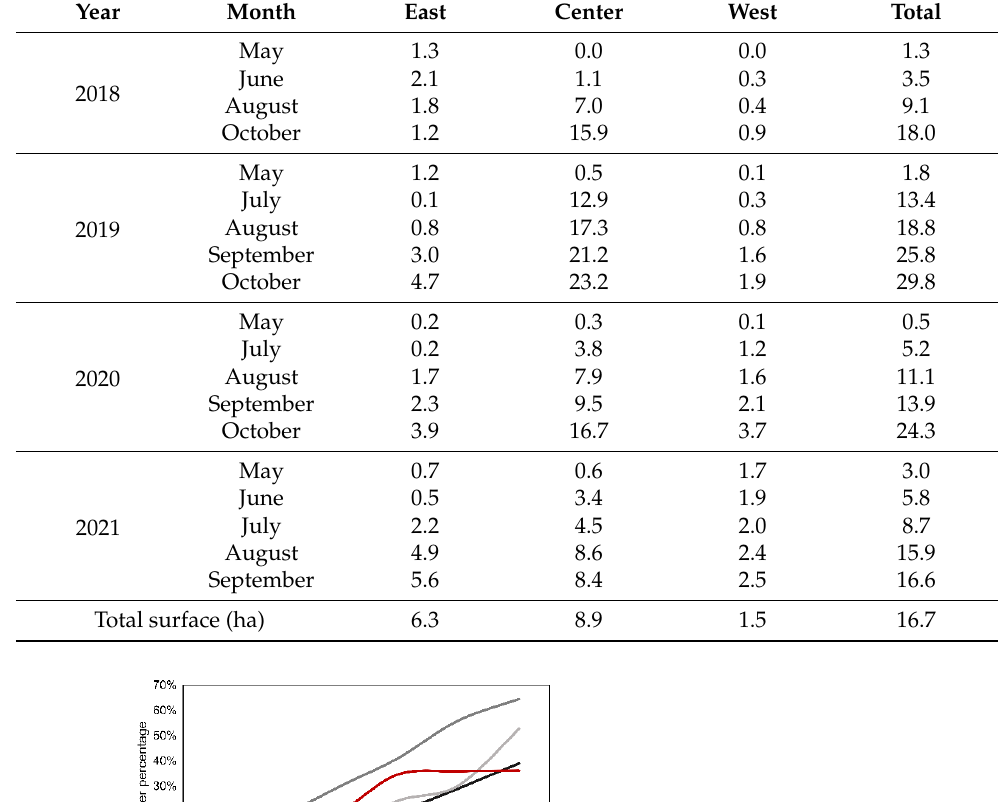
Table 3. Estimated water hyacinth surface occupation (in hectares) from the analyzed periods, from